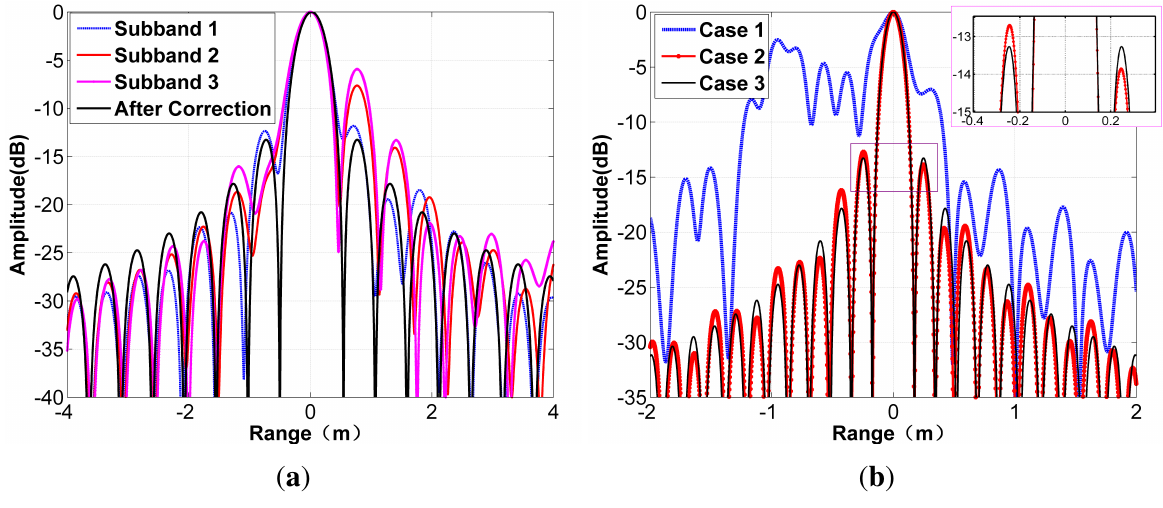
Figure 8. Range compression simulation results: ( a ) compression results of the sub-band signal; ( b ) compression results of synthetic bandwidth for the three cases (1, ignoring timing error; 2, applying the conventional cut-paste method; 3, implementing the improved cut-paste